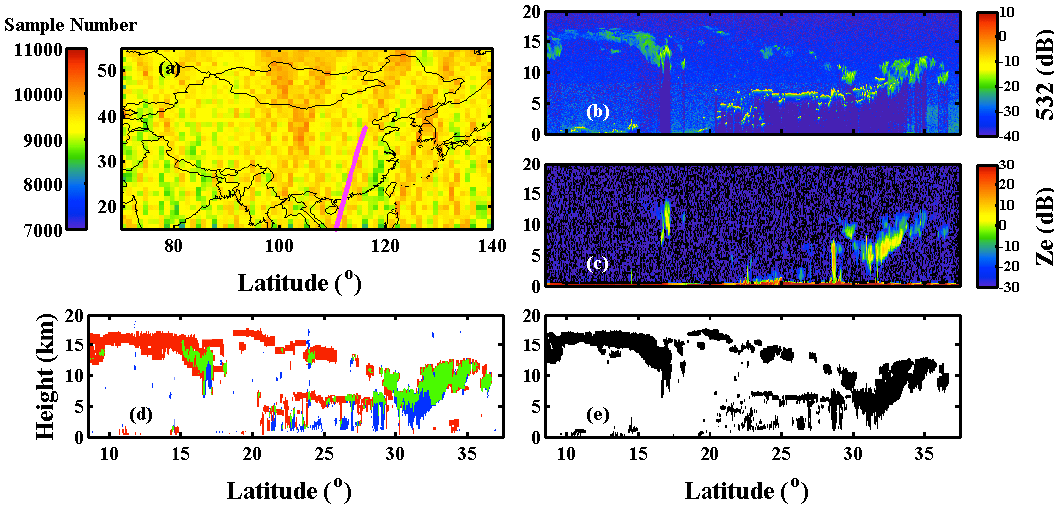
Figure 1. An example of A-Train satellite measurements and cloud detections on 31 May 2008. ( a ) Sample number of the four-year A-Train satellite measurements over the study region, overlaid with the magenta line indicating the location of the case; ( b ) Cloud–Aerosol LIdar with Orthogonal Polarization (CALIOP) total attenuated backscattering (TAB) at 532 nm; ( c ) Cloud Profiling Radar (CPR) reflectivity (Z e ); ( d ) clouds detected with CloudSat 2B-GEOPROF (blue) and CALIOP level 2 5-km cloud layer product (red), green regions represent clouds seen from both products; and ( e ) clouds detected with CloudSat 2B-CLDCLASS-LIDAR product.